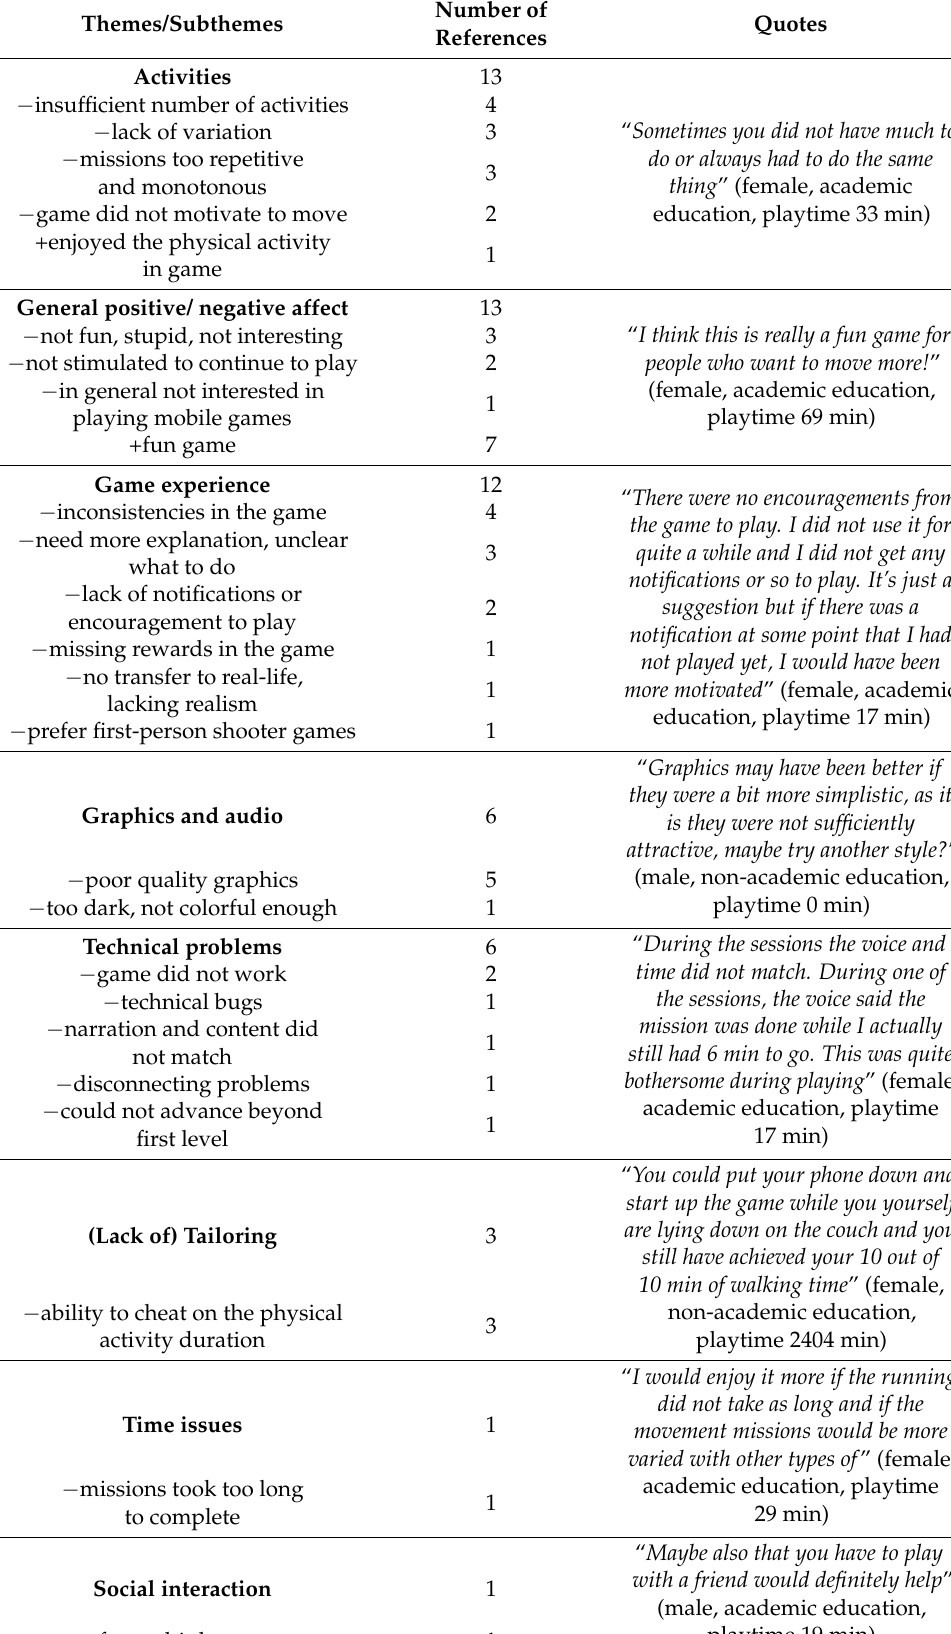
Table 5. Comments provided by participants in the non-tailored